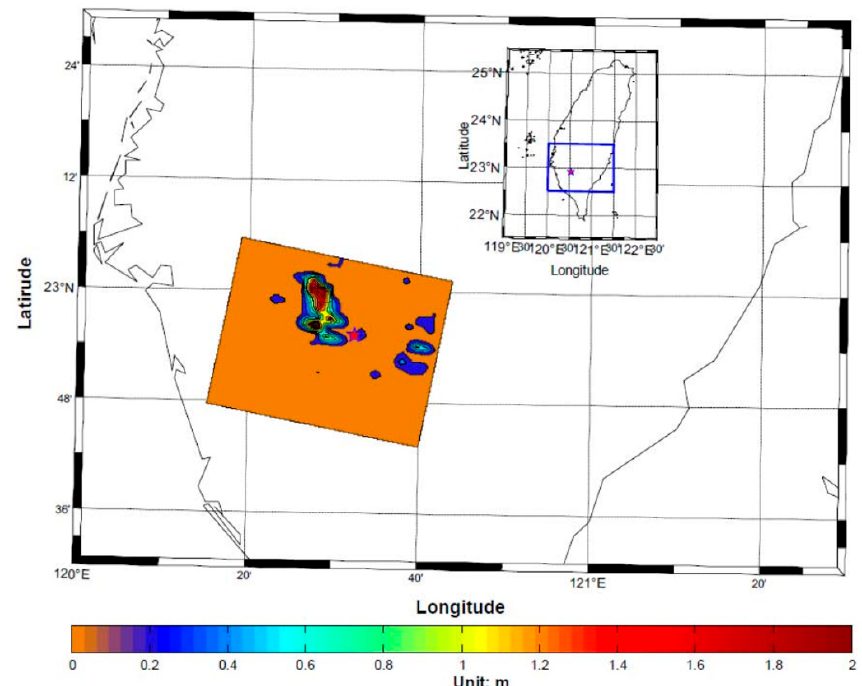
Figure 4. Slip distribution on the indicated fault derived using the source inversion technique. The maximum slip value was approximately 2.4 m. The star represents the epicenter of the Meinong earthquake.